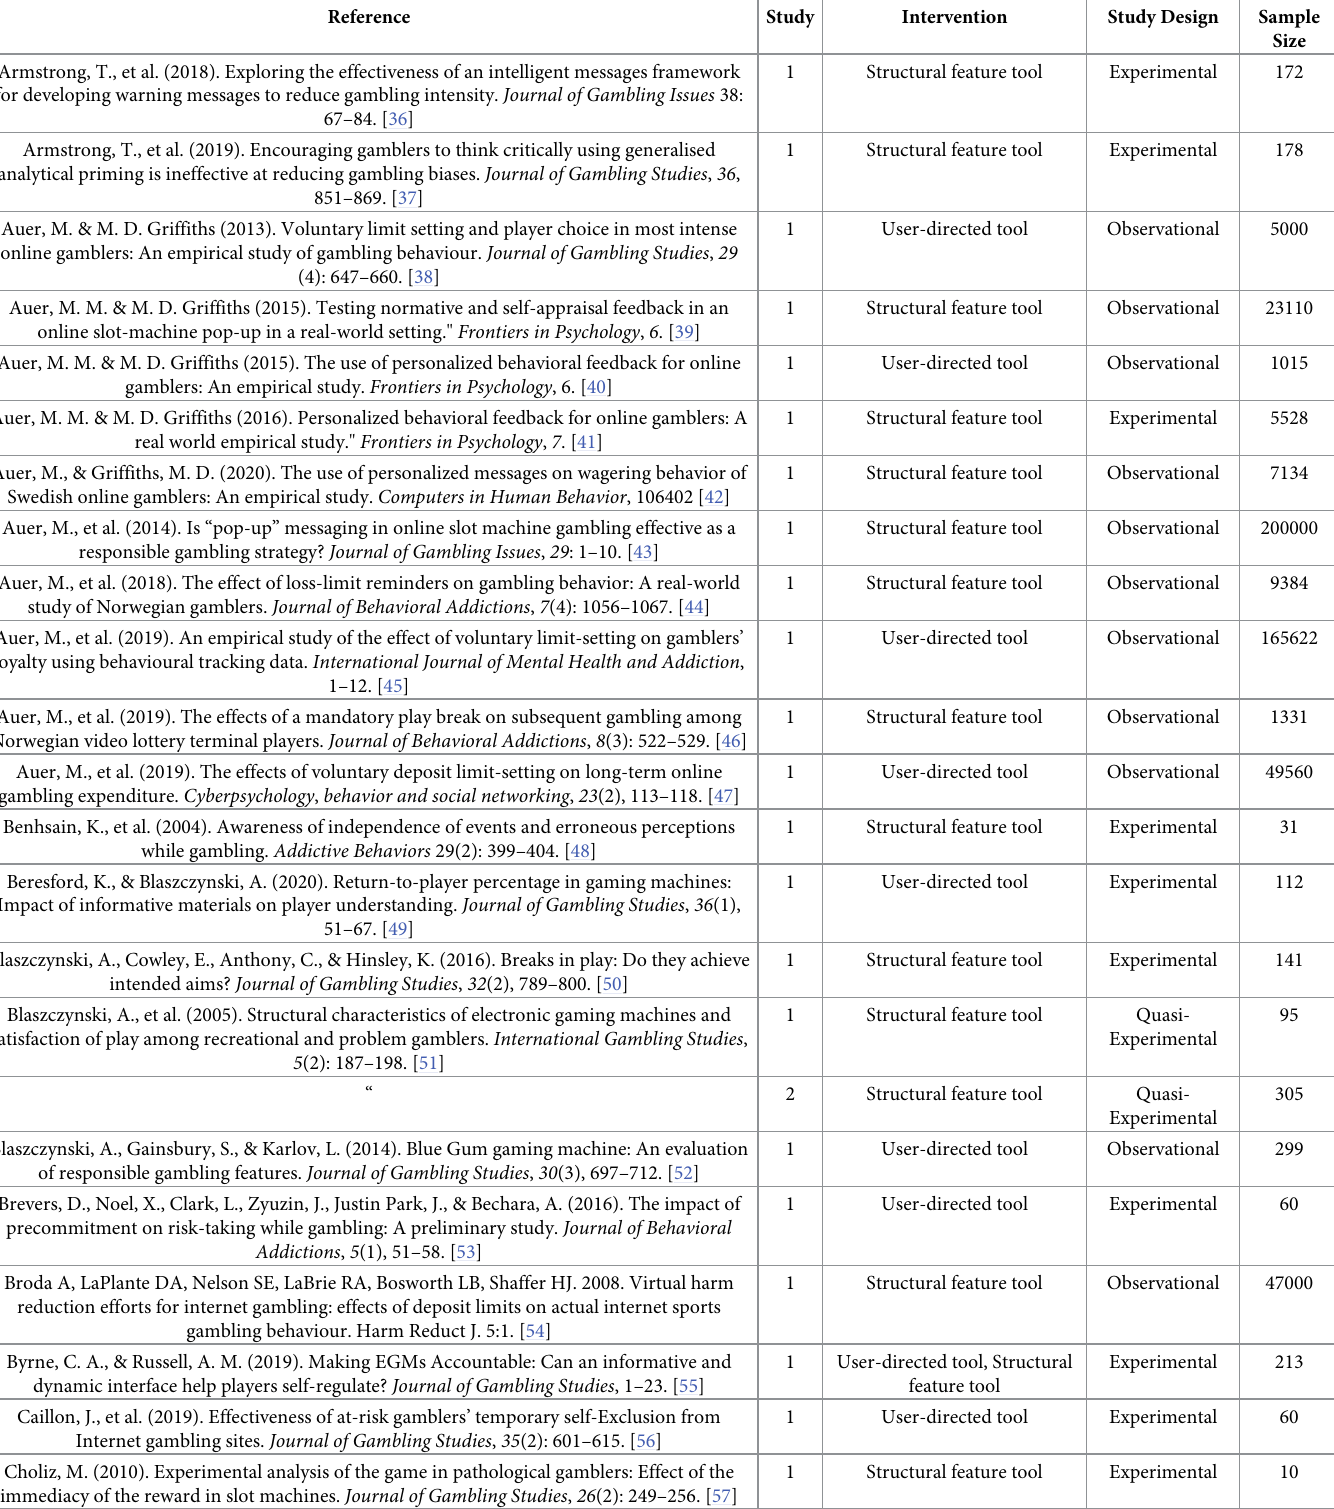
Table 2. Characteristics of studies included in scoping